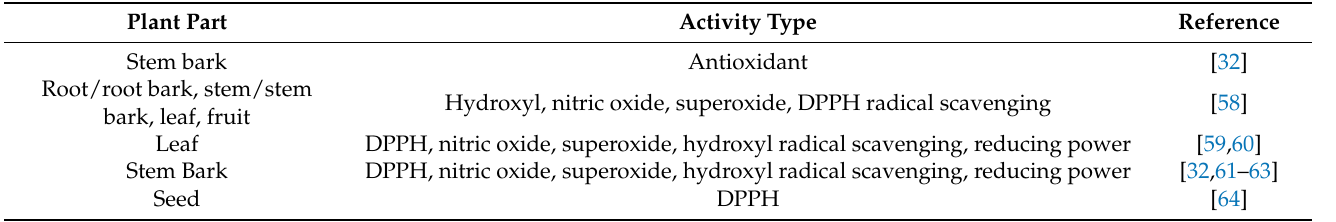
Table 4. Free radical scavenging and antioxidant activity of Oroxylum